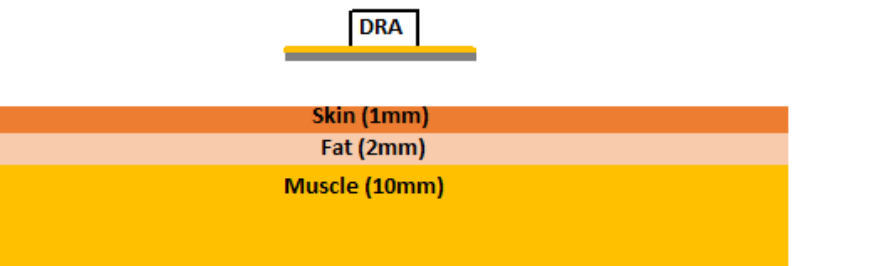
Figure 2. A single DRA element above the body phantom. Table 3. Human-body-tissue parameters at 28 GHz.